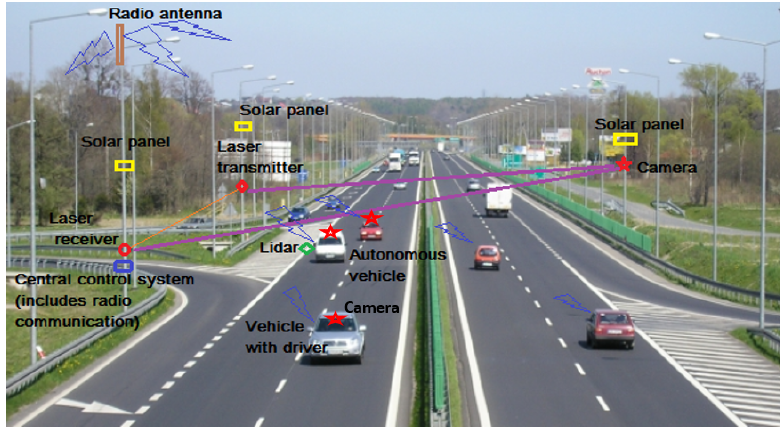
Figure 14. Proposal for a system to increase traffic safety in real traffic